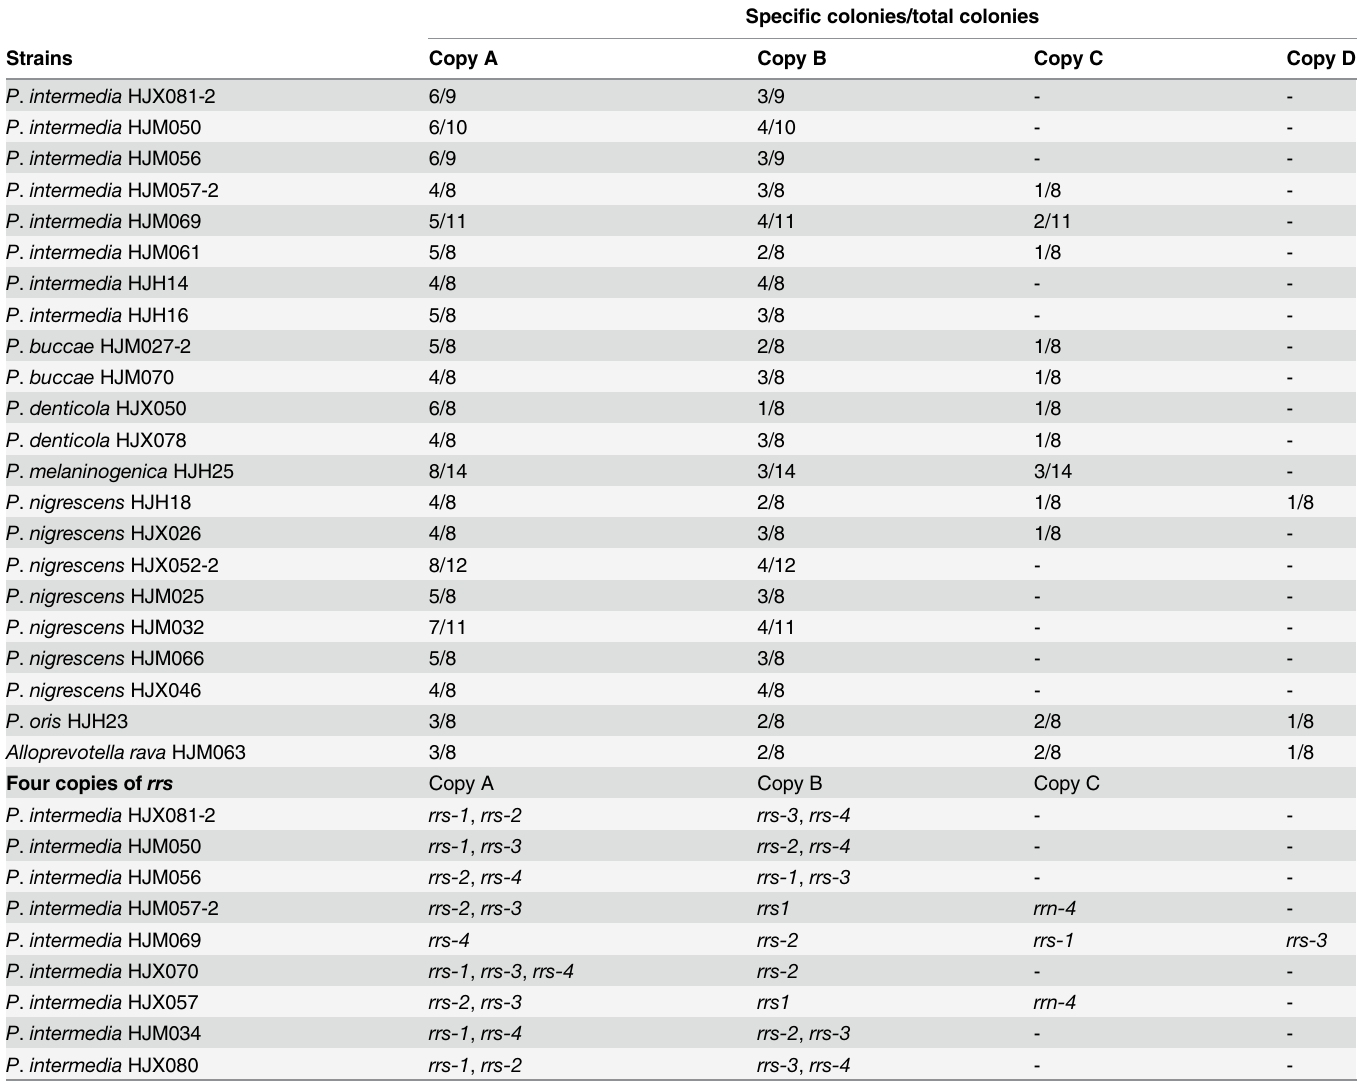
Table 1. 16S rRNA gene cloning of 22 Prevotella spp . clinical isolates and four copies of rrs sequencing of 9 Prev otella intermedia clinical